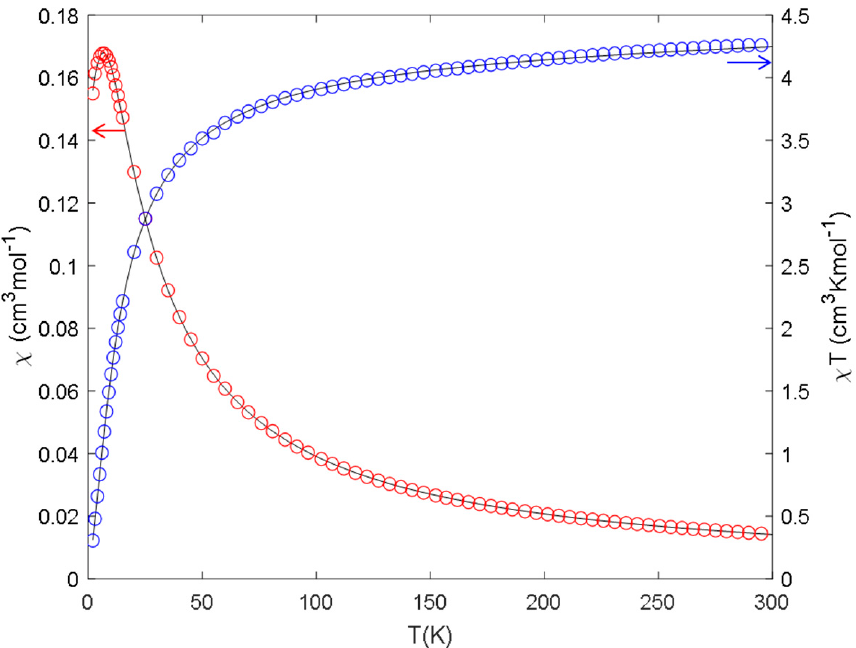
Figure 9. Thermal variations in the magnetic susceptibility ( χ ) and χ T product for compound 1 . The solid line represents the best fit according to the model.